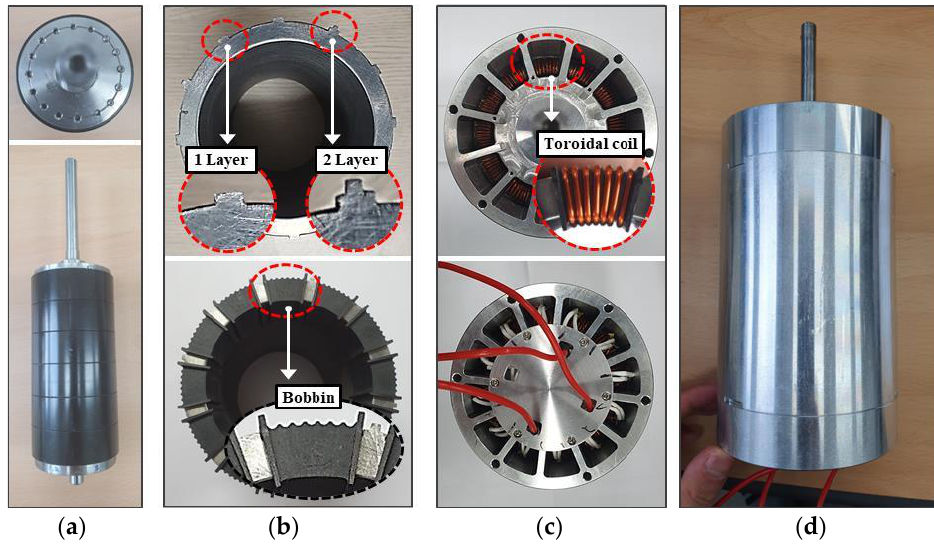
Figure 17. Prototype components: ( a ) Rotor, ( b ) Stator yoke and bobbin, ( c ) Bottom view, and ( d ) Side view.